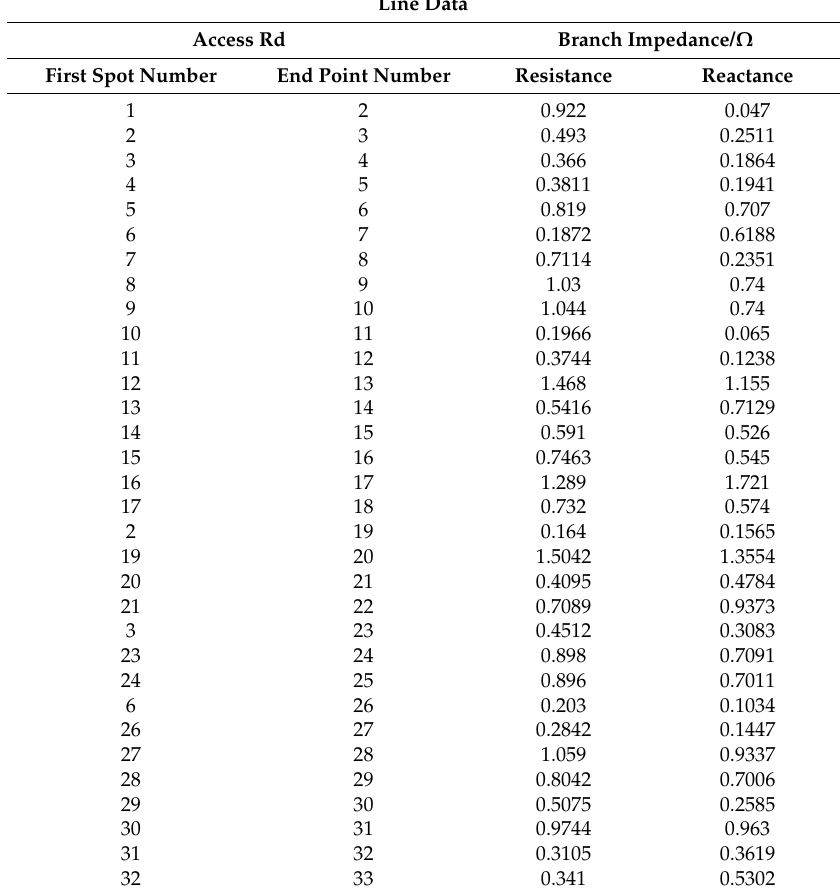
Table A1. Parameters of 33-bus distribution